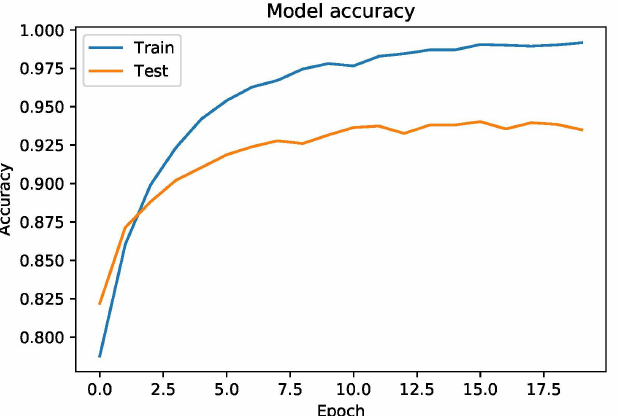
Figure 5. Training and Testing accuracy on heart failure-clinical-record